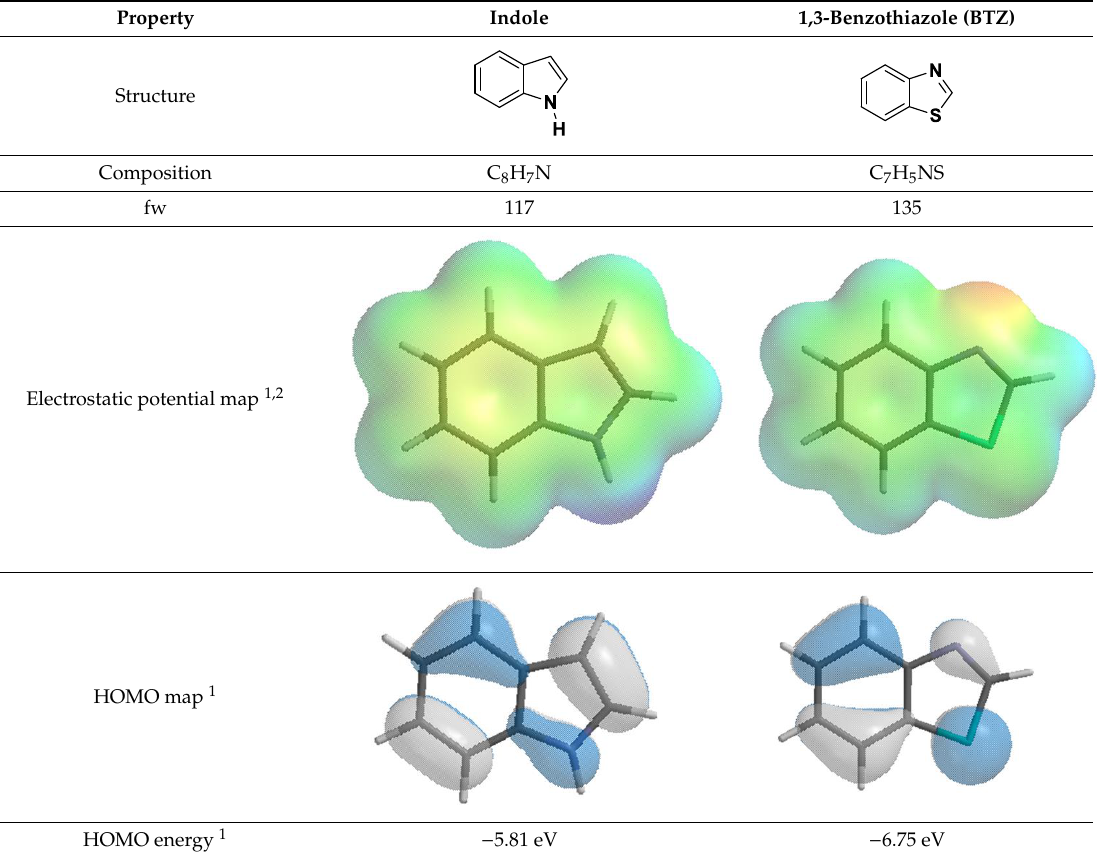
Table 1. Main physicochemical features of indole and 1,3-benzothiazole rings.